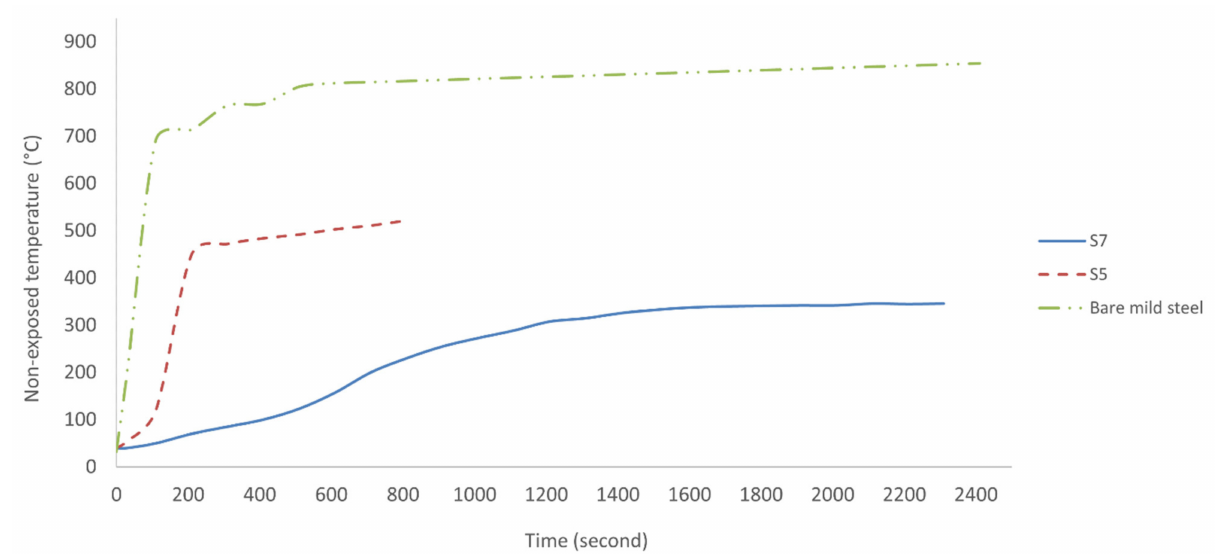
Figure 19. Result of fire-retardant